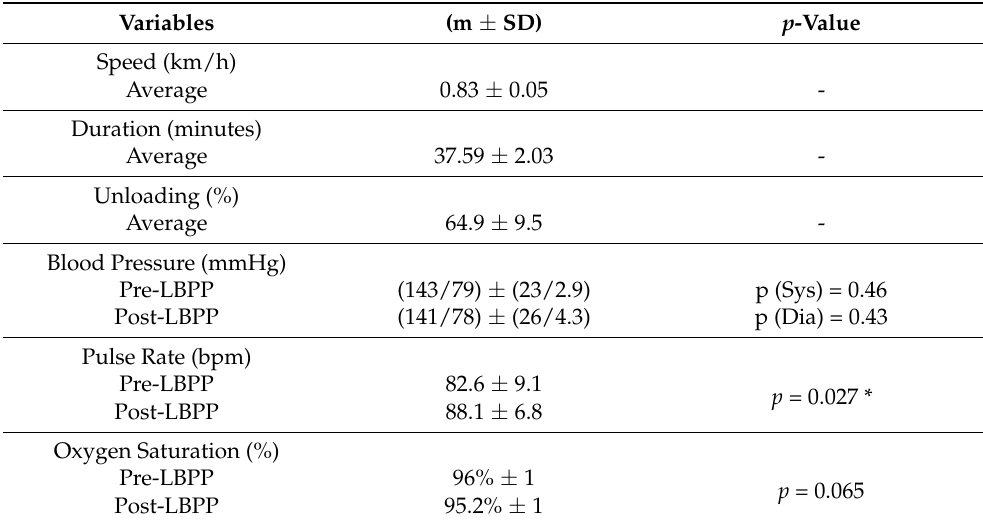
Table 2. The lower body positive pressure treadmillsession details and cardiovascular responses ( n =